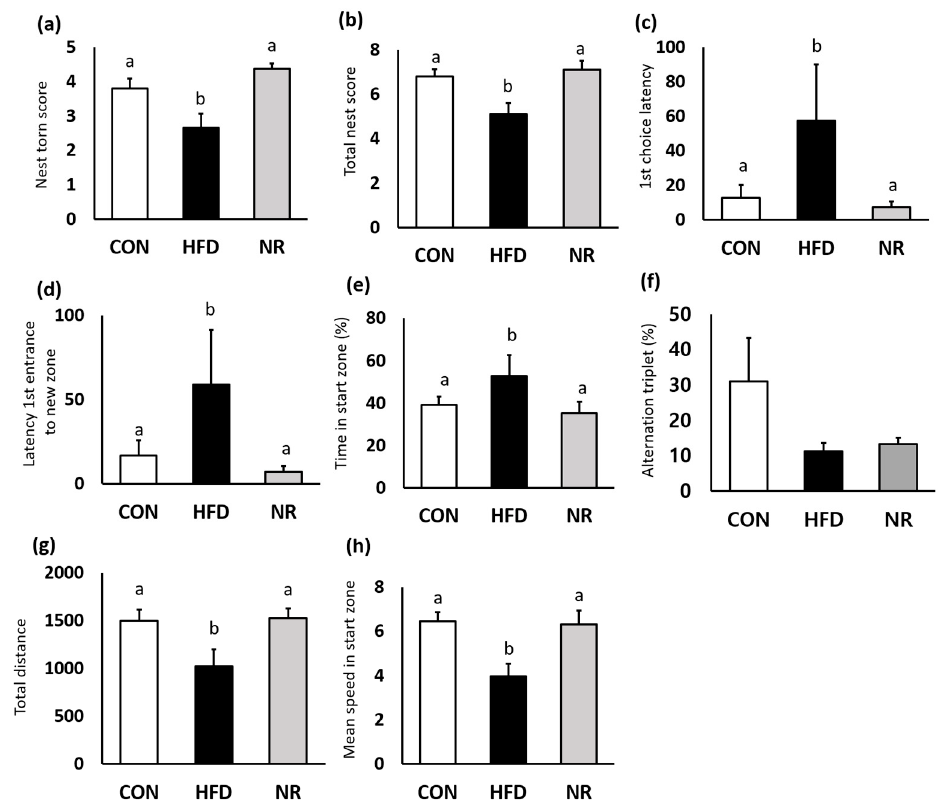
Figure 4. The effects of nicotinamide riboside (NR) on behavior tests. ( a ) Nest torn score and ( b ) total nest score were evaluated from nest construction test. ( c ) First choice latency, ( d ) latency first entrance to new zone, ( e ) time in start zone (%), ( f ) alternation triplet (%), ( g ) total distance, and ( h ) mean speed in start zone are analyzed from the Y-maze test. Values represent the mean ± SEM. Values with different letters in the same variable are significantly different ( p < 0.05). CON, control; HFD, high-fat diet.